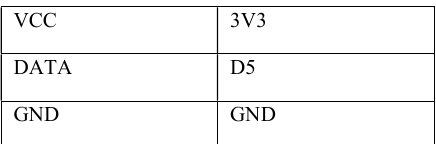
Table 3. Pin configuration between node MCU and